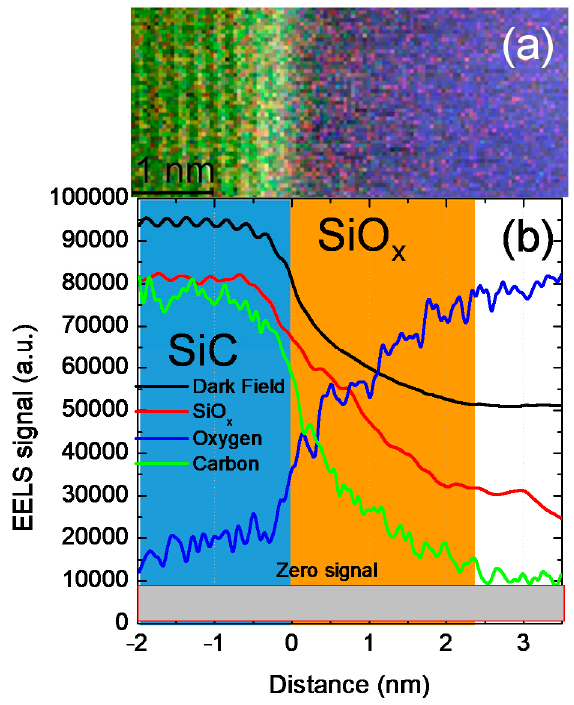
Figure 13. ( a ) High-resolution spectrum imaging cross section STEM image of the SiO 2 /4H-SiC interface. ( b ) EELS spectra of carbon, oxygen, and partially oxidized silicon (SiO x ). More details on these analyses are reported in Reference [52].